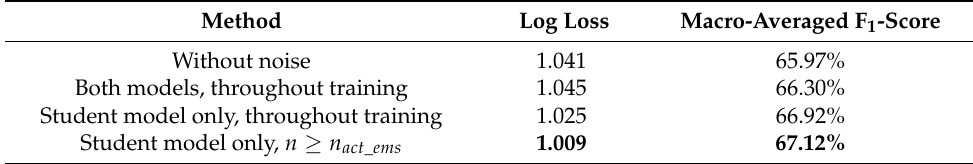
Table 7. Performance comparison with various noise addition